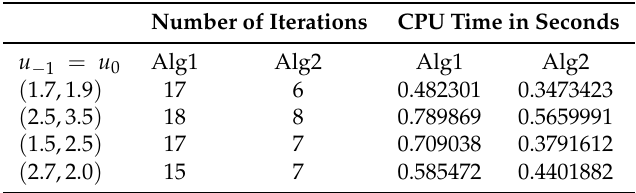
Table 6. Figures 1–4: Algorithm 1’s numerical comparison with Algorithm 1 in